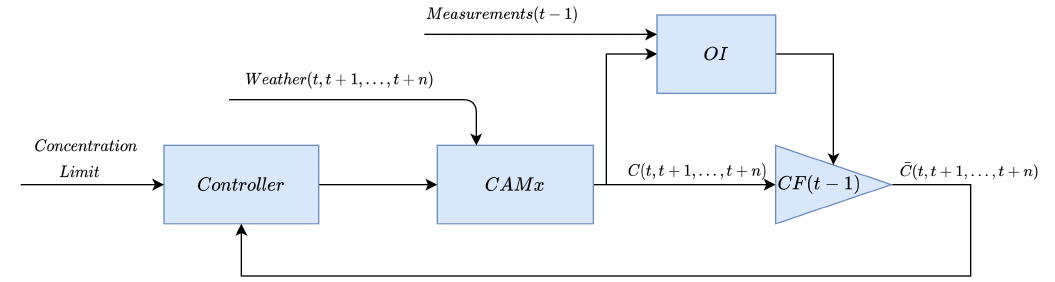
Figure 1. Overall System